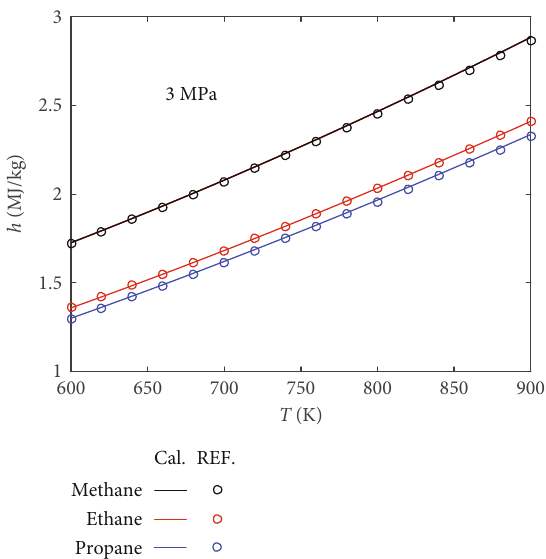
Figure 4: Comparison of constant-pressure speci fi c heat capacities of methane, ethane, and propane under